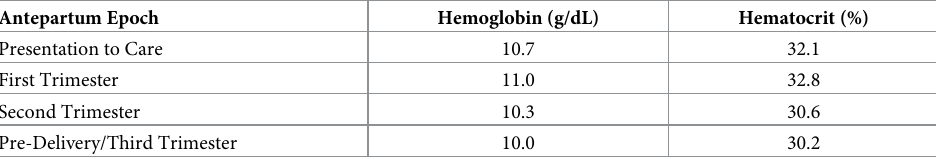
Table 4. Anemia defined, fifth percentile values of a normal, uncomplicated